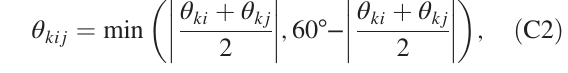
FIG. 7. (a) Local view of the smoothed orientation map inset on the left of the snapshot shows the raw orientation map θ 6 before smoothing. The scale bar represents 20 μ m. (b) The output of the grain detection algorithm adapted from Dillmann et al. [29]. Each grain is colored according to the average particles within it. (c) Delaunay triangulation of the crystal-like particles. The grain edges are colored in black, the GB connectors in red, and the GB segments in blue. The inset shows the construction of a GB segment involving three particles i , j , and k (see text). (d) The output of the grain detection together with the GB segments colored according to their misorientation as indicated by the color